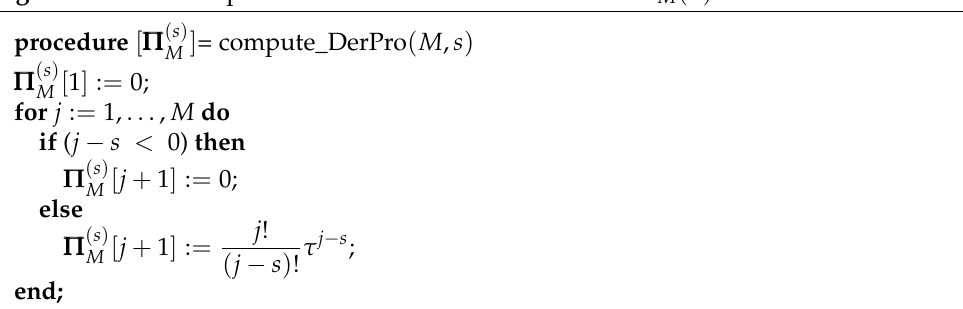
Algorithm 1 The computation of s -derivative of the vector ΠΠΠ M ( τ